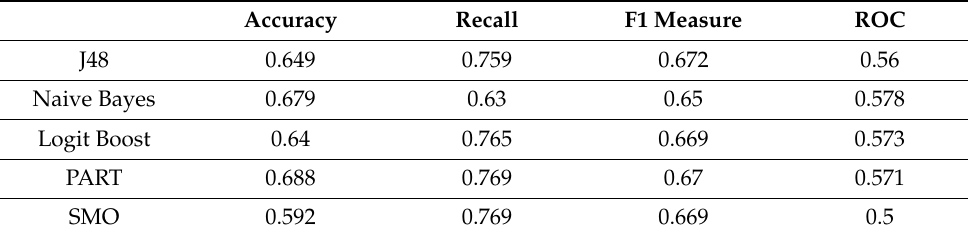
Table 4. Performance indicators obtained by the classification